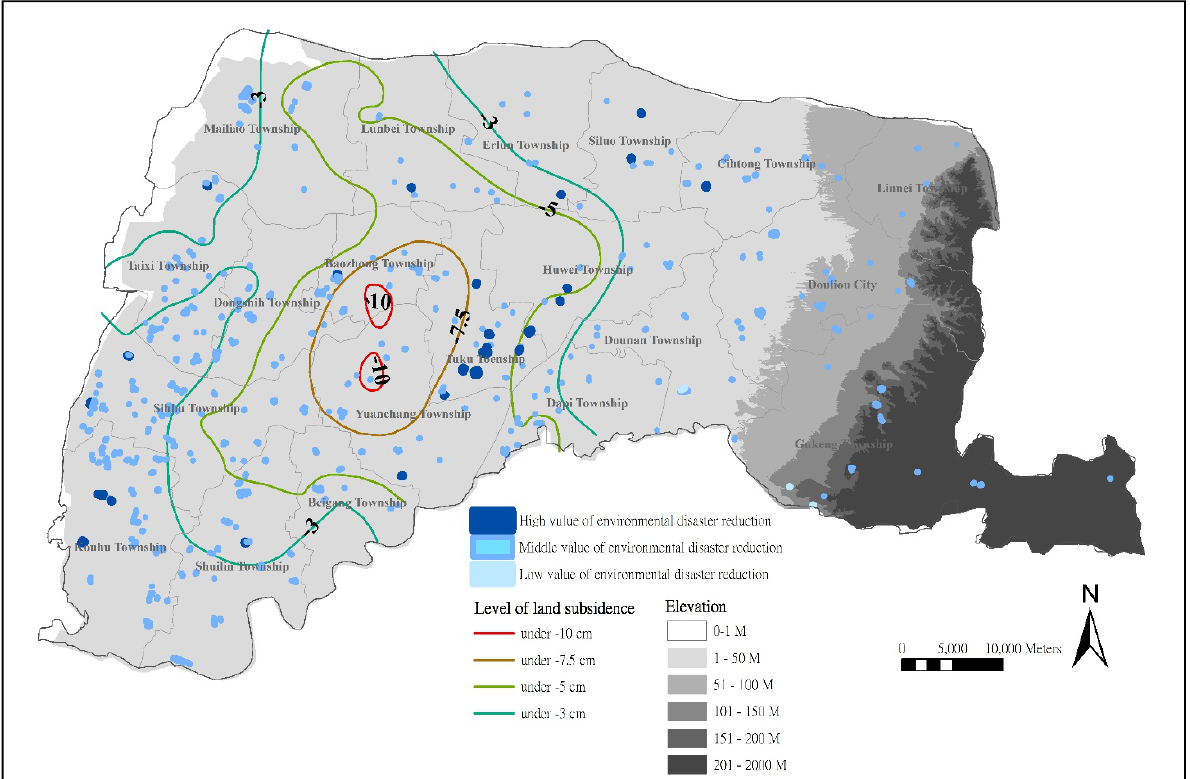
Figure 5. Distribution of farm ponds with preservation values of environmental disaster